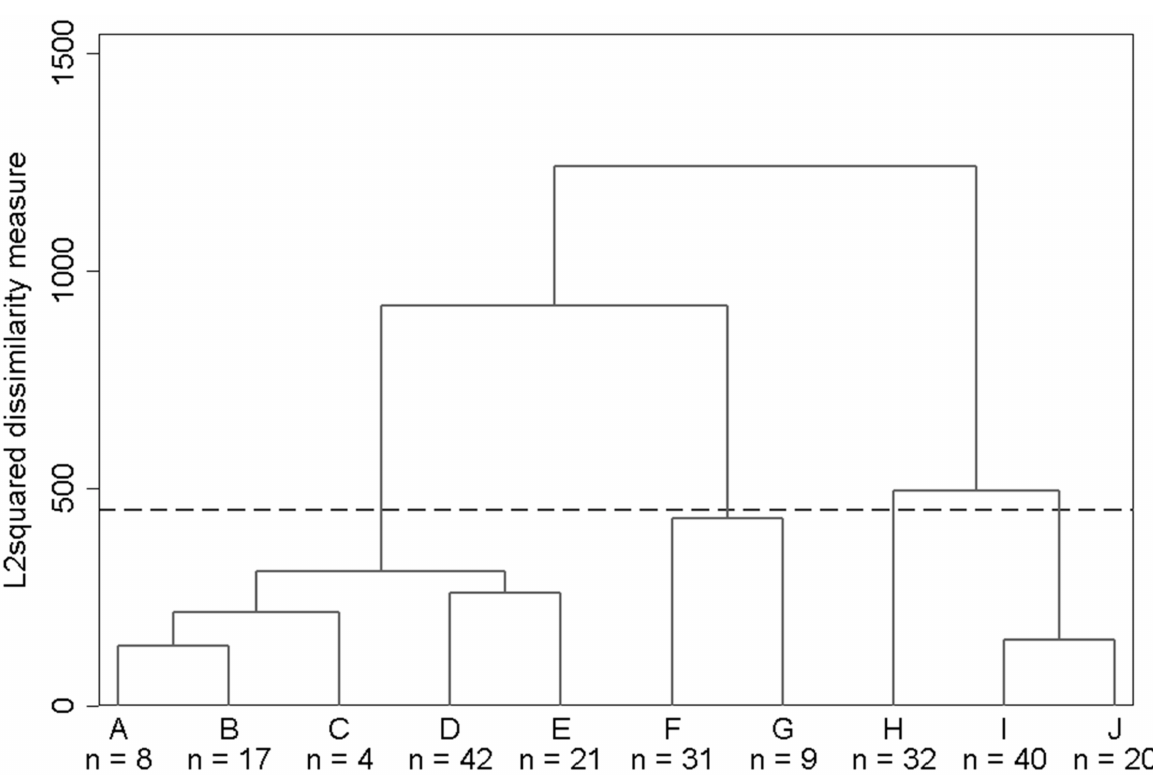
Figure A1. Dendrogram for cluster analysis. Table A1. Statistical tests regarding mean final exam grades of each Cluster and previous year final exam